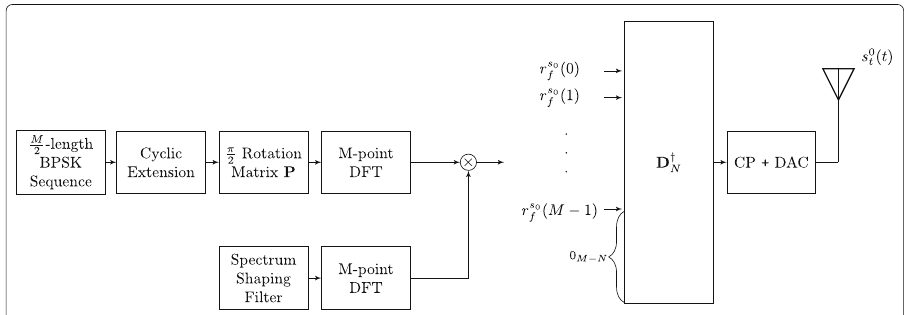
Fig. 7 Transmitter architecture for p ort 0 DMRS waveform generation using method